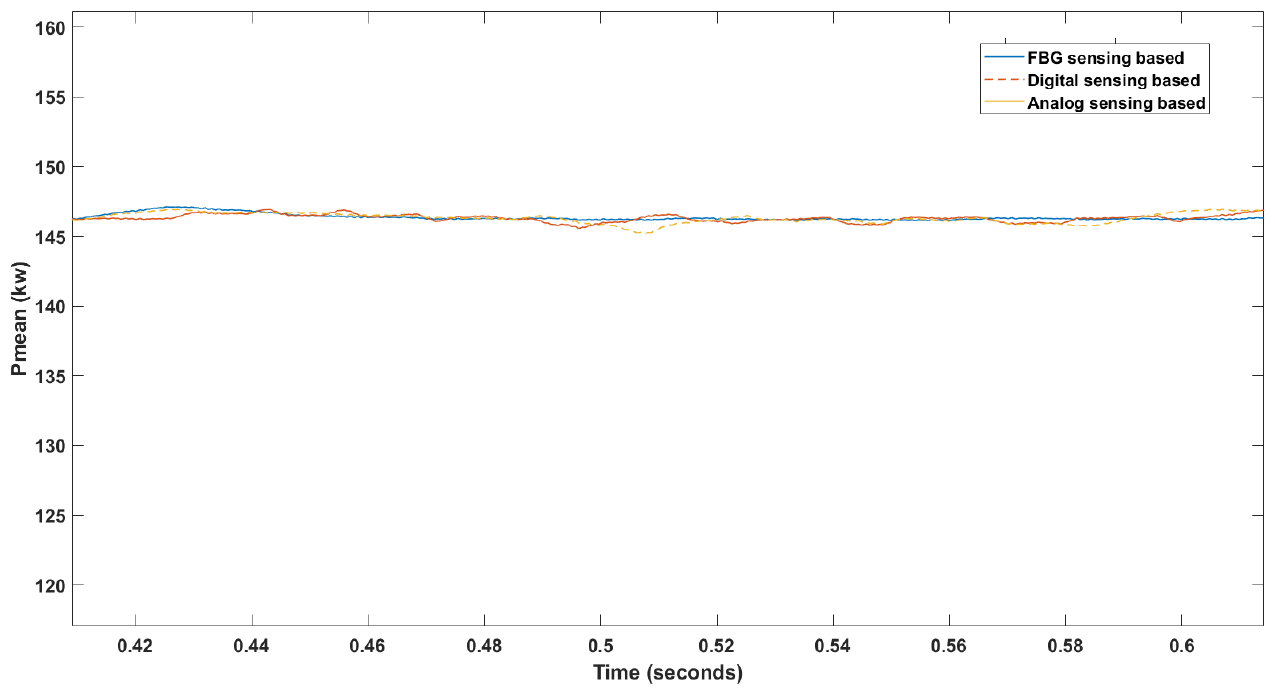
Figure 17. Output metrics at the potential point of the battery bank under EMI.